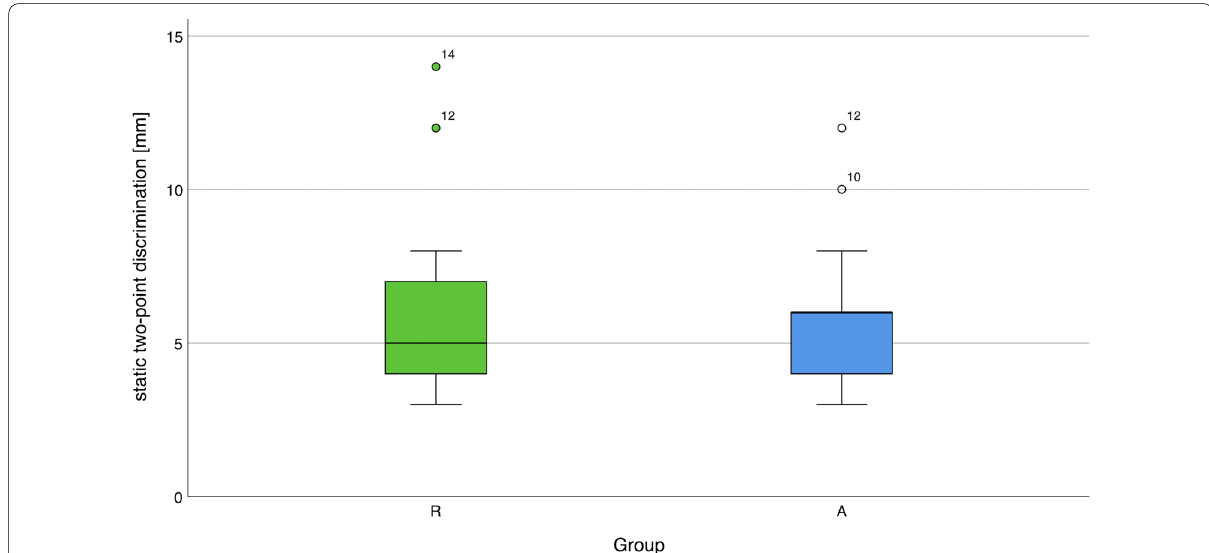
Fig. 4 Boxplots comparing the static two-point discrimination in groups R and A. Whiskers extend to a maximum distance of 1.5 interquartile ranges. Outliers are beyond these bars